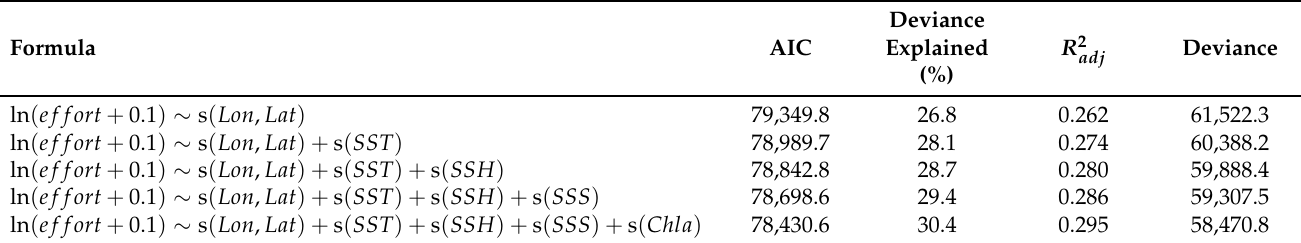
Table 4. Statistical parameters of GAM model (0.25 ◦ × 0.25 ◦ ).